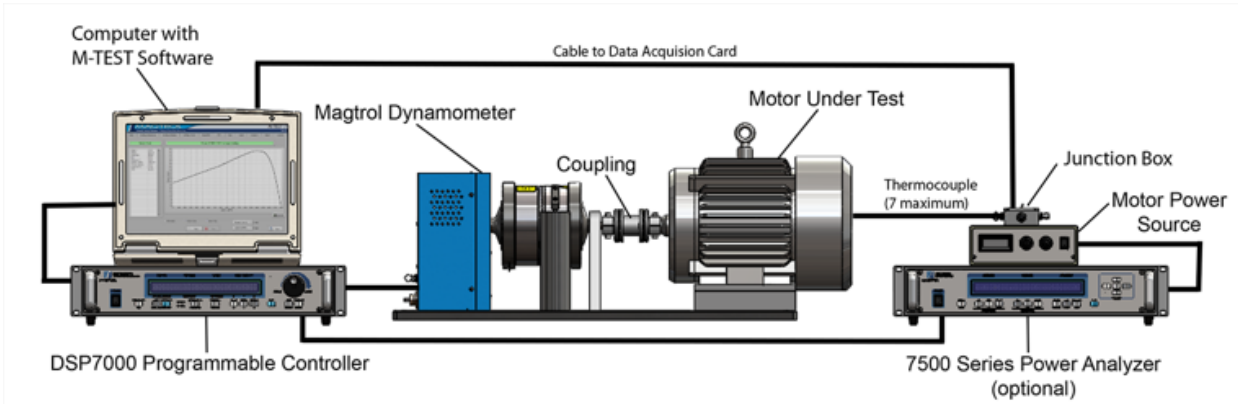
Figure 6. Typical cogging torque measurement test